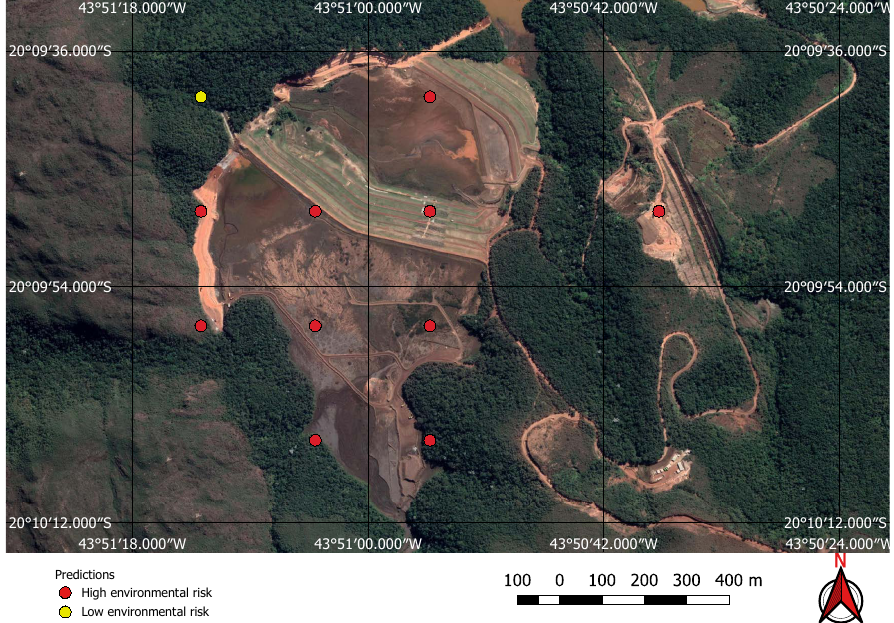
Figure 19. High environmental impact: iron mine tailings